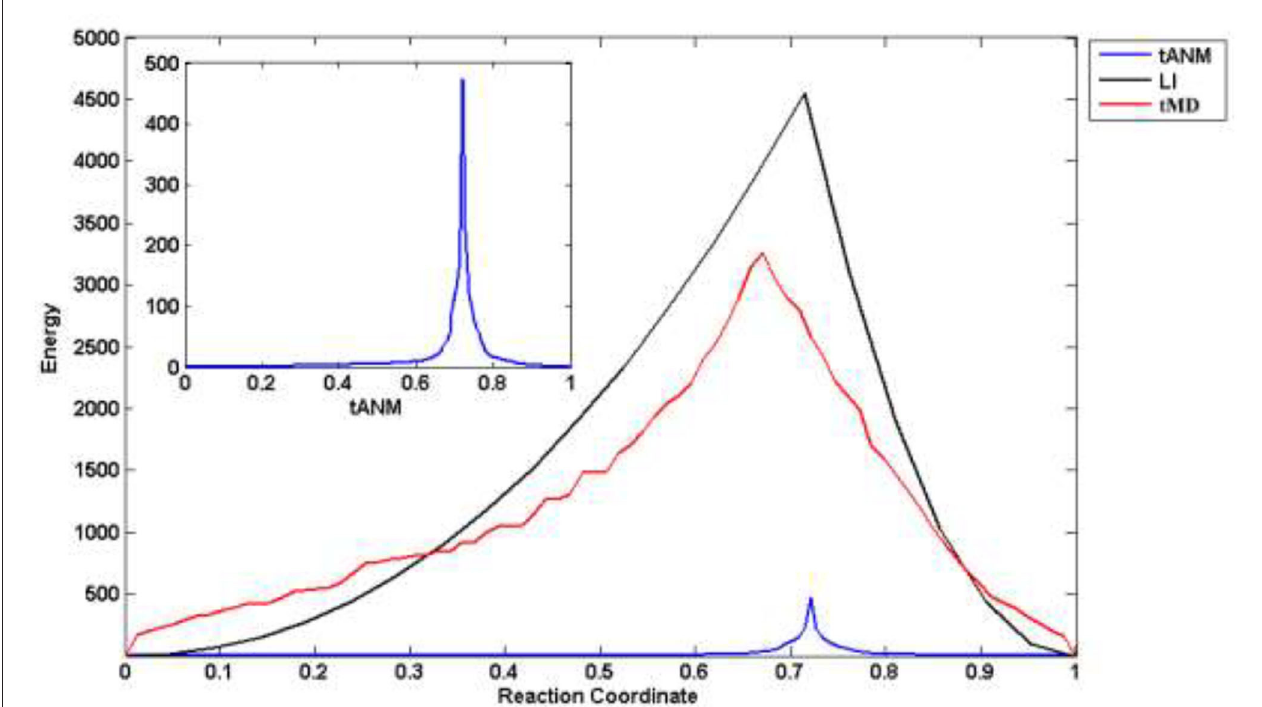
FIGURE 4 | The allosteric energy comparison of different methods. X-axis is the reaction coordinate, that is, the projection of the cumulative displacement on the original distance